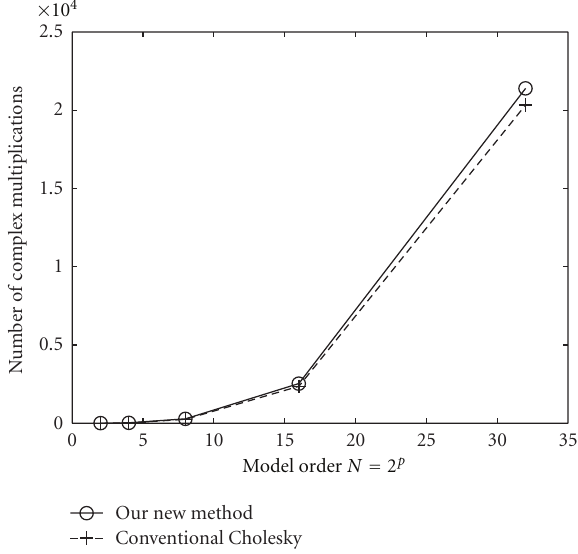
Figure 1: Computational complexity comparison (model order N = 2 p is fixed for one-time LSE or MLR) for Hermitian matrix inversion using conventional Cholesky factorization ( C (cid:2) R − 1 and our proposed new dyadic recursion ( C (cid:2) R − 1